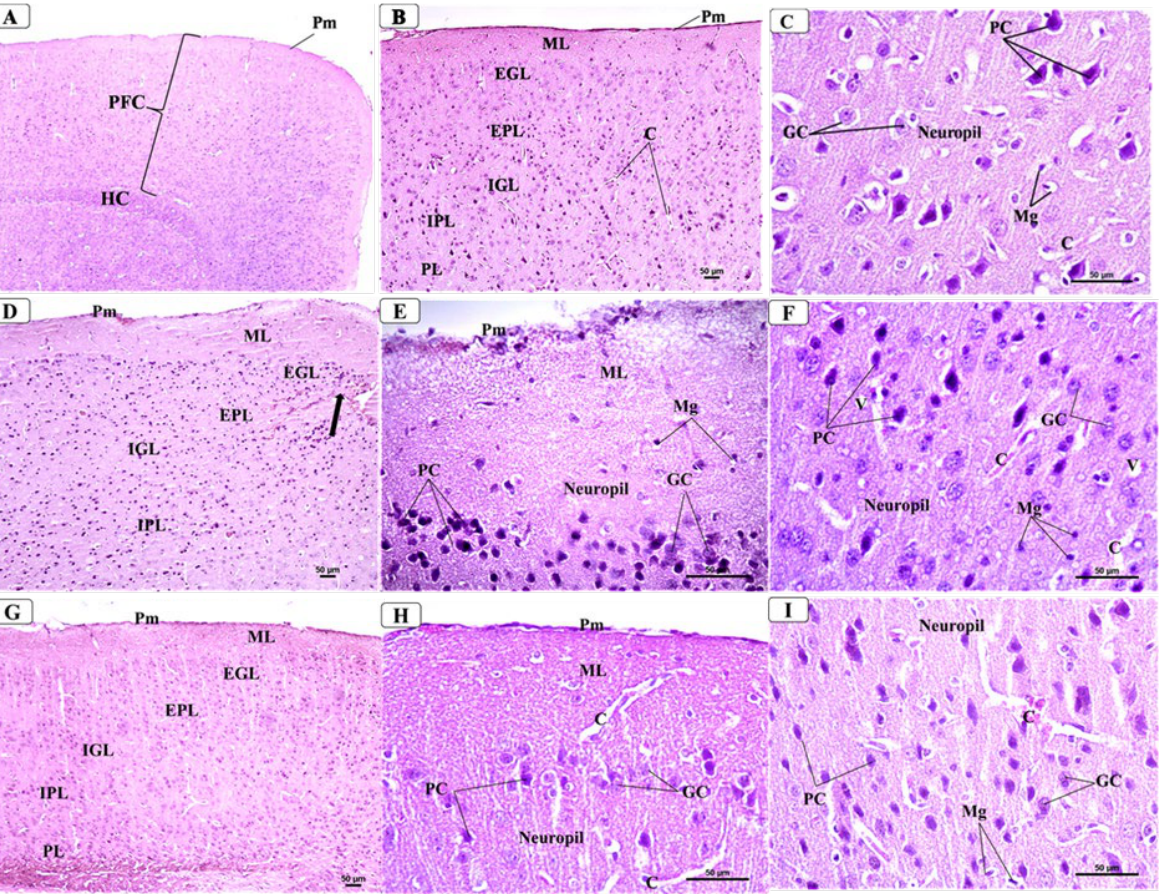
Figure 6. Representative photomicrographs of the PFC: from control group showing: ( A ) General view of PFC covered by thin pia matter (Pm). HC = Hippocampus. ×40 ( B ) Normally arranged layers in the form of molecular layer (ML), external granular layer (EGL), external pyramidal layer (EPL), inner granular layer (IGL), inner pyramidal layer (IPL), and polymorphic layer (PL) from outside to inside. pm = pia matter. ×100 ( C ) Lower layers that contained granular cells with vesicular nuclei (GC) and large pyramidal cells with their vesicular nuclei and basophilic cytoplasm (PC). The neu- ropil appeared pinkish and showed some microglial cells (Mg) and few capillaries ( C ). (×400). Rep- resentative photomicrographs of the PFC from CPZ group showing: ( D ) Disorganized delineation of the cortical layers and thickened pia matter (pm), thickened molecular layer (ML), and hypercel- lularity (thick arrow) of the external granular layer (EGL) and external pyramidal layer (EPL). ×100. ( E ) Thickened molecular layer (ML) that appeared rarefied and pale due to a smaller number of fibers and cells. Many pyramidal cells (PC) appeared darkly stained and irregular in shape. Some granular cells (GC) showed abnormal shape with darkened cytoplasm × 400 ( F ) Lower layers that contained many pyramidal cells (PC), which were darkly stained and irregular in shape with con- densed nuclei and surrounded by vacuolated pale areas. Some granular cells (GC) appeared shrunken and deeply stained. Moreover, many neuroglial cells (Ng) appeared shrunken and deeply stained. ×400. Representative photomicrographs of the PFC from CPZ + BCA group showing: ( G ) Improved organized layers with normally appeared pia matter (pm). ML = molecular layer, EGL = external granular layer, EPL = external pyramidal layer, IGL = internal granular layer, IPL = internal pyramidal layer, and PL = polymorphic layer × 100 ( H ) Nearly normal histological appearance of the upper layers with normally appeared pia matter (pm). ×400 ( I ) Pyramidal cells (PC) that ap- peared normally or shrunken with dark cytoplasm, blood capillaries ( C ), and neuroglial cells (Ng) were observed. ×400.